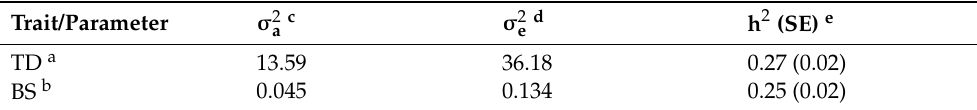
Table 2. Estimates of variance components and heritability for P. salmonis resistance, defined as time to death (TD) and binary survival (BS), in a rainbow trout breeding population using whole-genome sequence imputed genotypes.